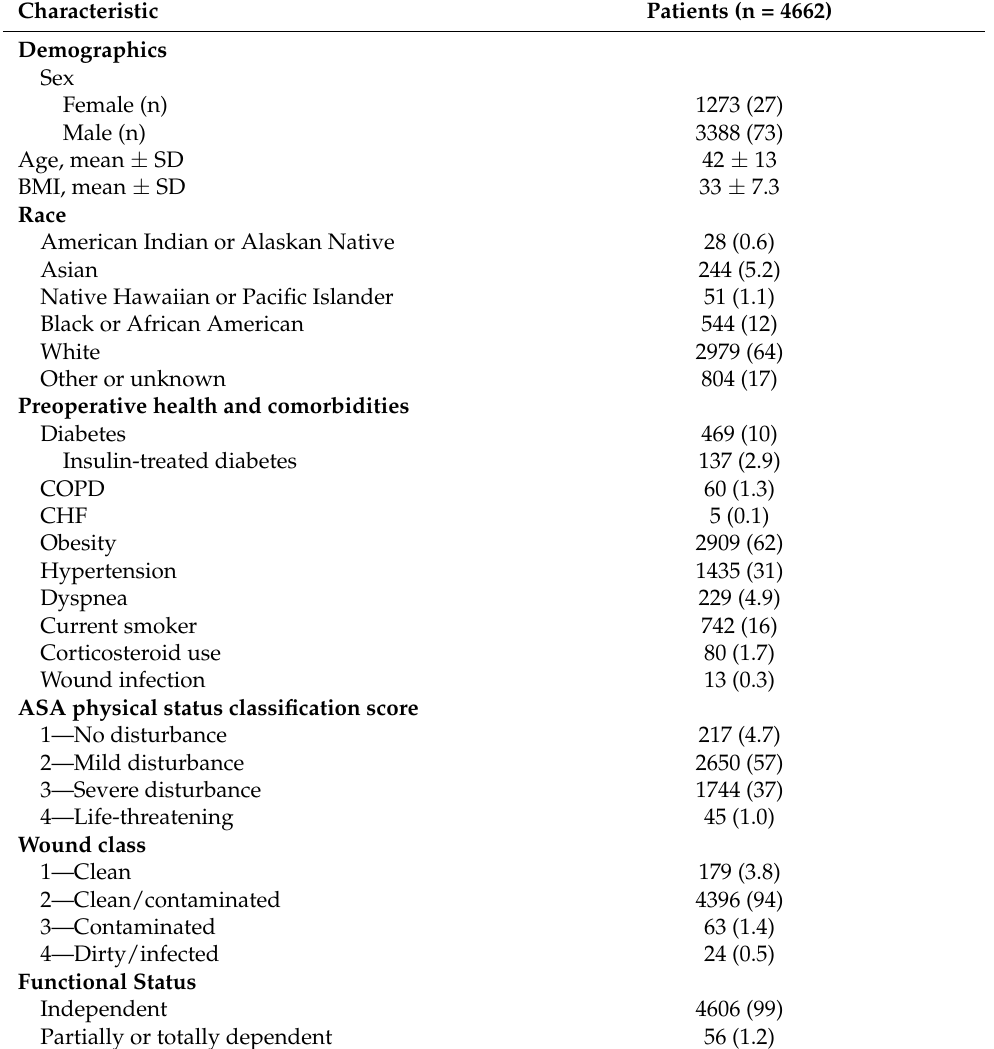
Table 1. Patient demographics and comorbidities. Reported as n (%), unless otherwise